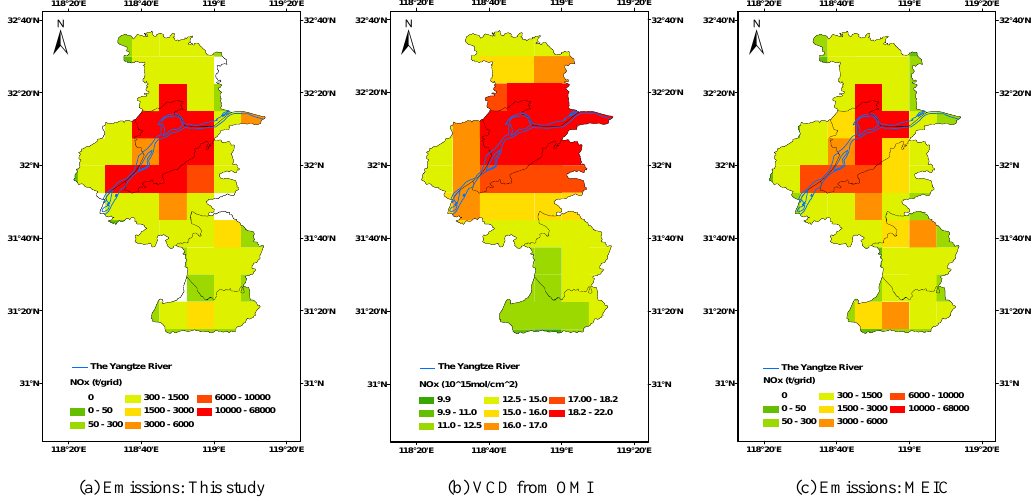
Figure 5. (a) Spatial distribution of city-scale NO x emissions in this study, (b) summer NO 2 vertical column density (VCD) from OMI, and (c) NO x emissions from MEIC for Nanjing, 2010. The resolution is 0.125 ◦ × 0.125 ◦ .